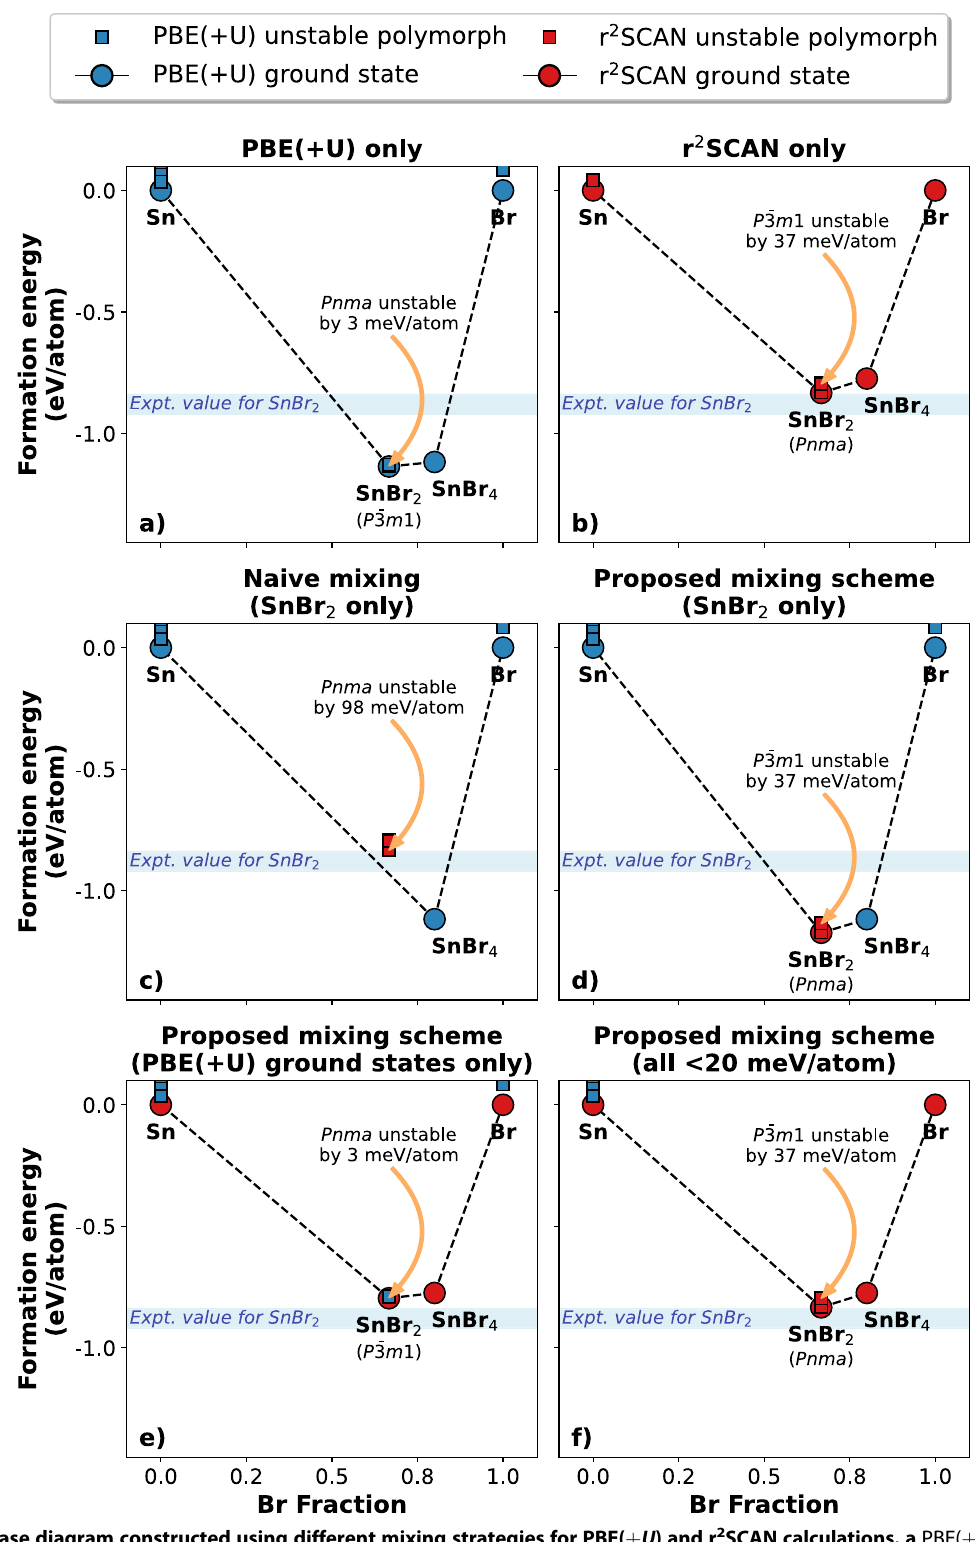
Fig. 2 Sn – Br phase diagram constructed using different mixing strategies for PBE( + U ) and r 2 SCAN calculations. a PBE( + U ) only; b r 2 SCAN only; c naive mixing of formation energies, where all SnBr 2 polymorphs are computed in r 2 SCAN and all other materials are in PBE; d the same set of energies as c , but employing our mixing scheme (Rule #2); e r 2 SCAN for all reference states (i.e., PBE( + U ) ground states) and PBE( + U ) for all other materials; f r 2 SCAN for all materials within 20 meV per atom of the PBE( + U ) convex hull. The numerical value in parentheses indicates the energy above hull of the experimental ground state Pnma polymorph of SnBr 2 . The shaded blue regions represent the estimated range of experimental formation energies for SnBr 237 . Tabulated r 2 SCAN and PBE( + U ) energies for all materials are available as Supplementary Data (see Supplementary Note